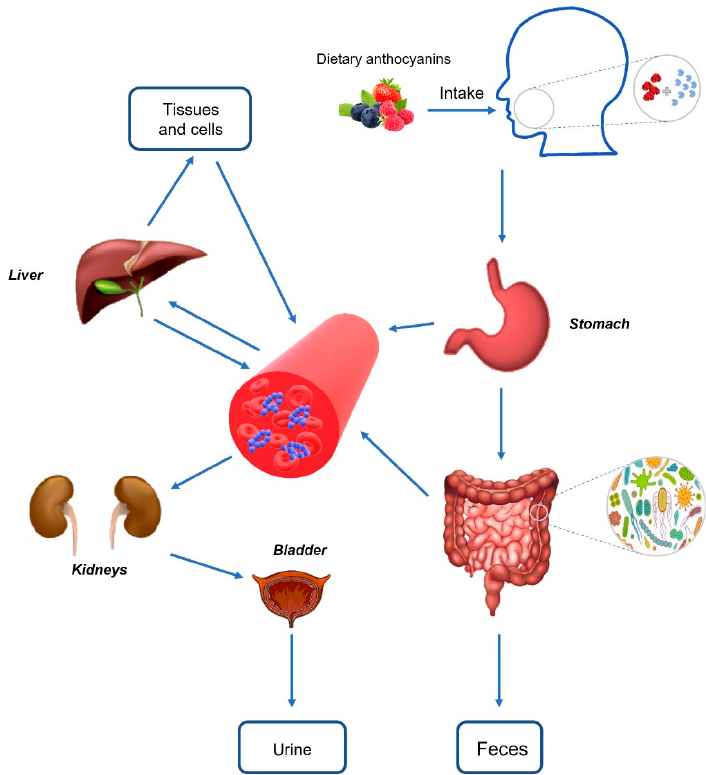
Figure 2. Scheme of anthocyanin absorption and metabolism [75]. Anthocyanins can interact with enzymes in the oral cavity after being ingested, resulting in enzymatic hydrolysis of anthocyanins. When reaching the gastric cavity, anthocyanins undergo a series of transformations under different digestive enzymes and acidic pH values and may be absorbed into the blood through active or paracellular transport. Anthocyanins reaching the intestine undergo phase I and II metabolism in the small intestine and are affected by intestinal microflora in the large intestine. All these newly formed metabolites and intact anthocyanins will be absorbed into the blood through a variety of mechanisms, and further metabolized in the liver or kidney, which enter the body cycle and are absorbed by the target organs and tissues. If not absorbed, they are discarded through urine and feces. 4. Effects of Anthocyanins on Endothelial Cell Aging and Cardiovascular Protection 4.1. Cell Senescence and Vascular Endothelial Cell Senescence Cell senescence is a permanent cell cycle arrest with replication ability [76] accompa- nied by specific changes in cell morphology and gene expression and function (Figure 3). Cell senescence can be induced by many factors, and telomere shortening is one of the main signs of senescence. Due to incomplete lag chain synthesis during DNA replication, the number of telomere repeats decreases with each cell division. This loss is compensated by telomerase. In somatic cells without telomerase expression, as the number of cell divi- sion increases, telomeres gradually shorten to the limit, leading to DNA double strand breaks [77]. DNA double strand breaks induce DNA damage by activating ATM/ATR and Chk1/Chk2, thereby activating p53 signaling pathway and triggering cell senescence [78]. There is evidence that aging can be reversed by activating telomerase. In particular, when telomerase genes are reactivated in these aging mice, premature aging in telomerase-